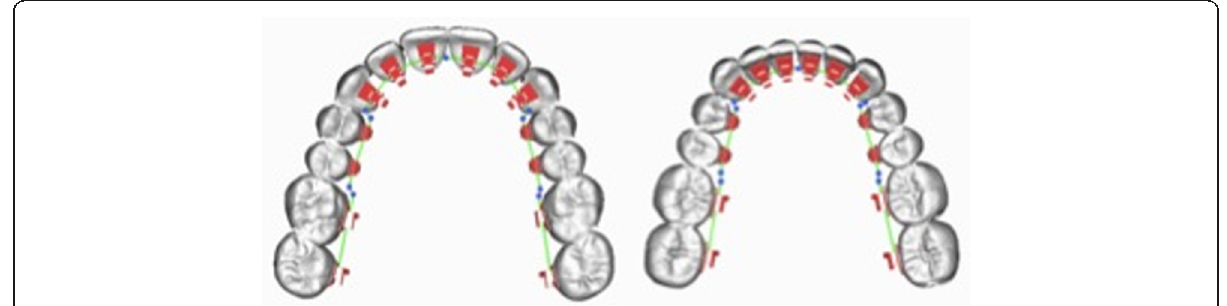
Fig. 1 Digital set-up of an ideal patient with moderate crowding using a lingual mushroom archwire (UMW and